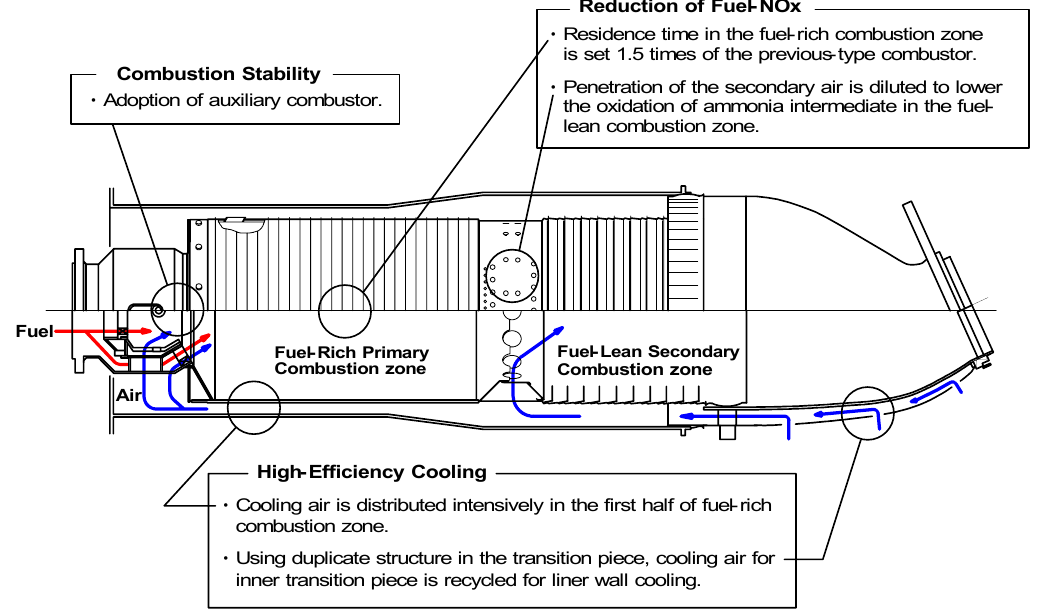
Figure 48. Design concept of 1773 K-class low-Btu fueled